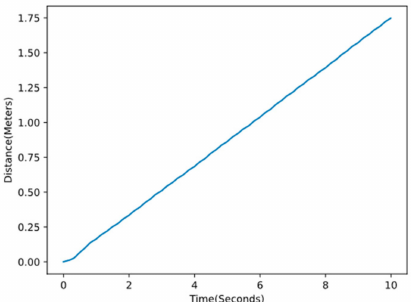
Figure 13. Picture showing the distance the center of gravity has